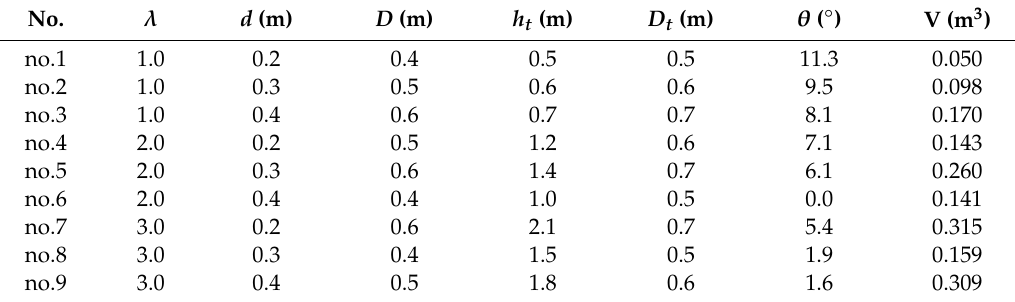
Table 5. Dimensional combination of the foundations of nine sizes ( V is the foundation volume).